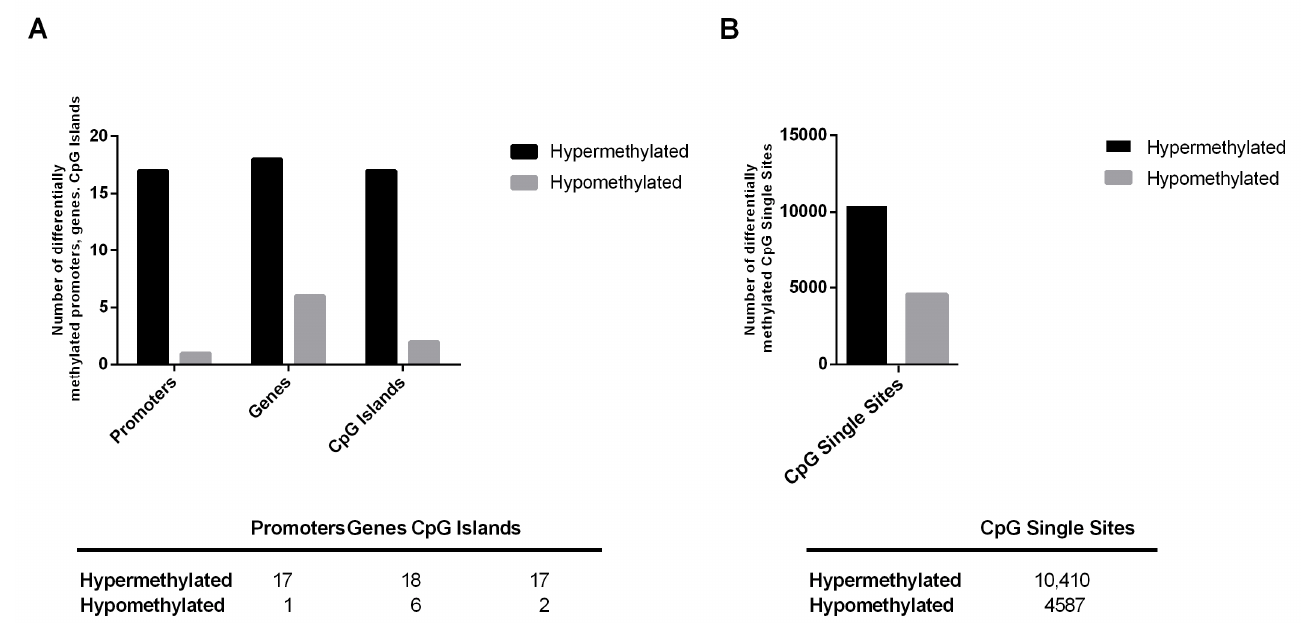
Figure 2. Methylation status in the comparison of CAD vs CTR. ( A ) Number of differentially methylated regions (DMRs) as promoters, genes and CpG Islands. ( B ) Number of differentially methylated CpG single sites (DMCs). p ≤ 0.05, Δ Meth > 20%.